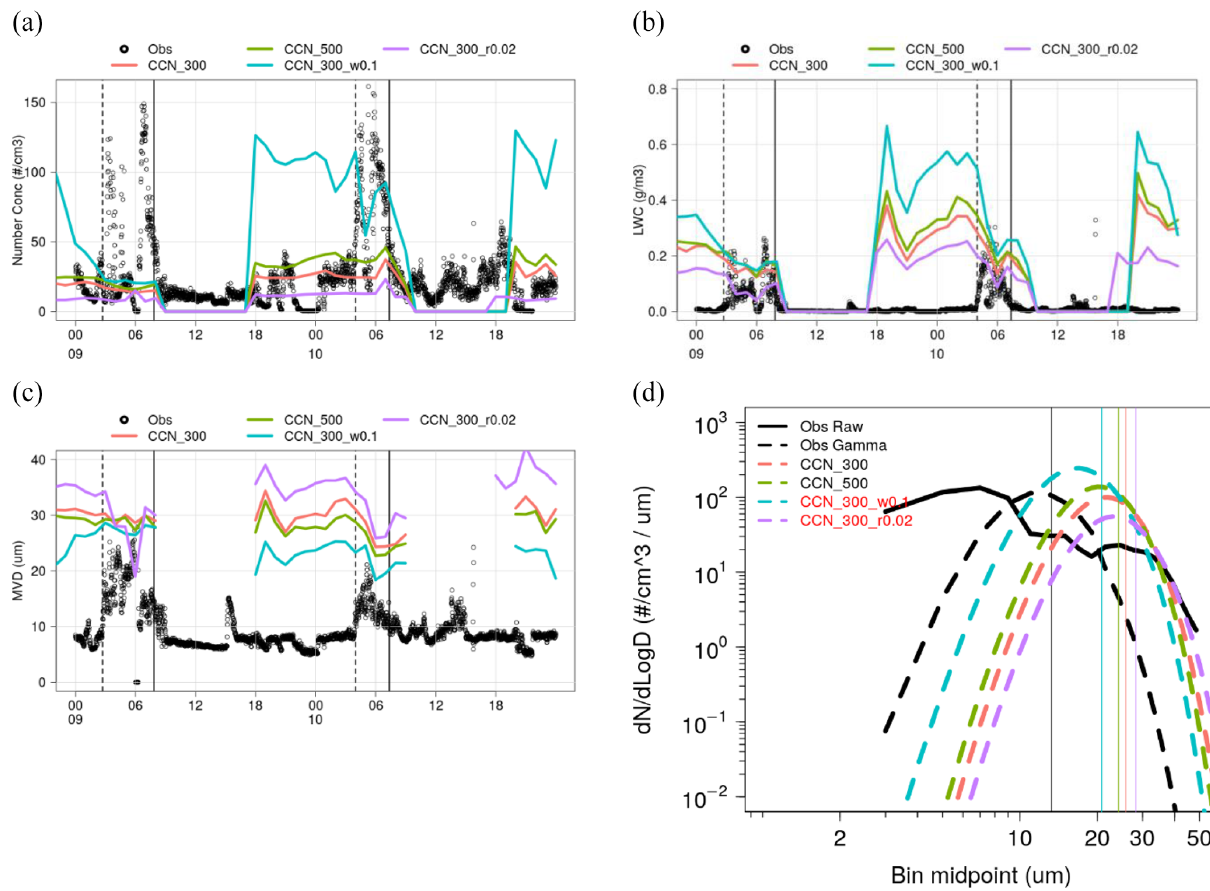
Figure 19. Observed and modelled DSD for (a) case 1 and (b) case 2. Black solid lines are the observed distributions. Black dashed lines are the equivalent theoretical gamma distribution applied to the observed data. Other dashed lines are model distributions. Vertical solid lines represent the